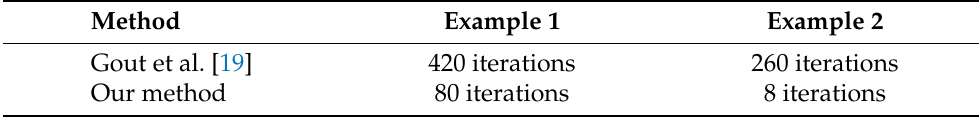
Figure 4. Using our proposed approach, the process does not require an initial guess, the interpolation conditions automatically initiate the process. Left : interpolation conditions. Right : final result after 80 iterations. Table 1. Gain of the automatic generated initial